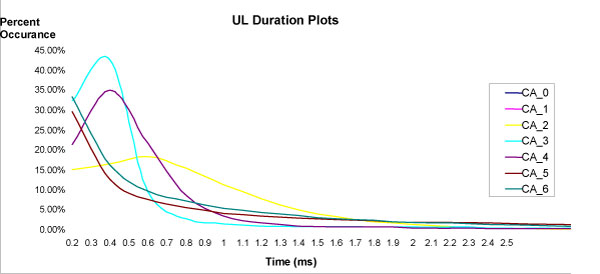
UL, the unbound terminus state, has shortest life for CA_3, i.e., CA_3 has strongest interaction with channel (and surroundings), neighboring variants (CA_2, CA_4) share this property to a lesser extent, and molecules with GC pairs more than 1 base-pair distant group very closely, the one molecule with no extra GC also separates with its own characteristic curve. This result is consistent with the increased reactivity of CA_3 to initiate complex formation [1], with weaker variants in CA_2 and CA_4, exactly as found experimentally [1-7].